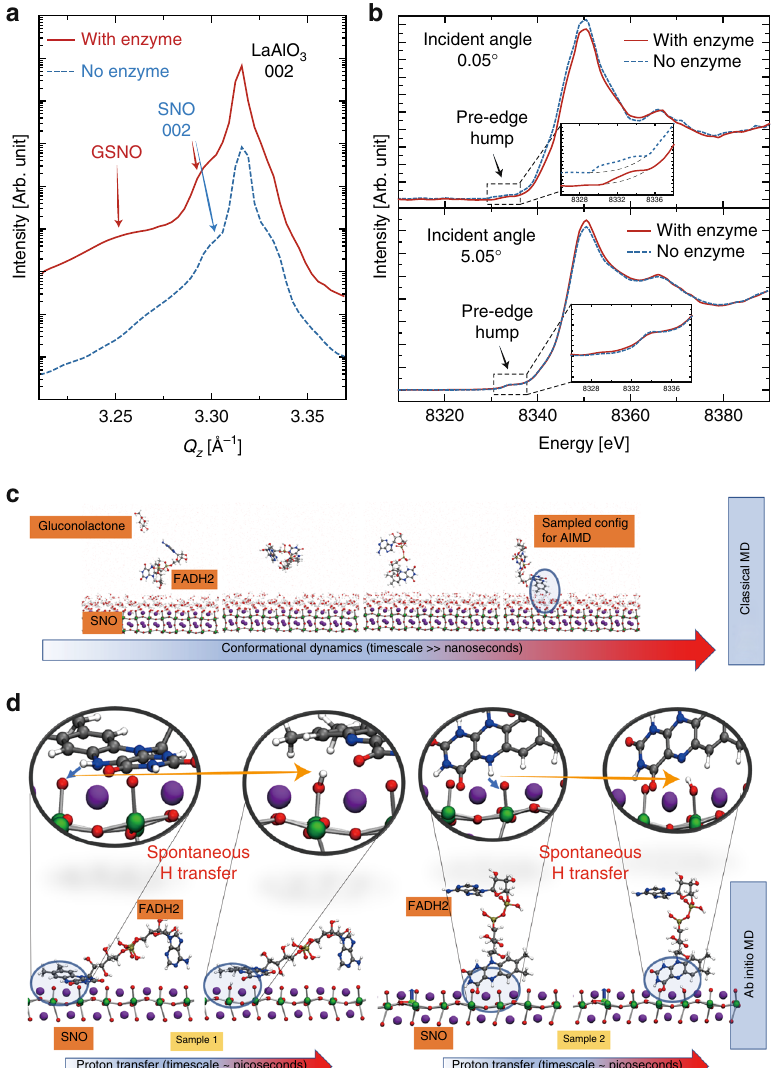
Fig. 3 Mechanism of the spontaneous reaction between the enzyme – SNO device and glucose. a Synchrotron X-ray diffraction scans of glucose-reacted SmNiO 3 (SNO) devices with and without glucose oxidase (GOx) enzyme modi fi cation. The scans are along Q z direction around the 002 peak of LaAlO 3 substrate (pseudocubic notation). b Angle-dependent X-ray absorption near edge spectroscopy (XANES) spectra on glucose-reacted SNO devices with and without GOx enzyme modi fi cation (Ni K-edge). At a surface sensitive incident angle of 0.05 o , XANES spectra acquired on the GOx-modi fi ed electrode on GSNO show pronounced reduction in the white line peak amplitude and the effective pre-edge humps, as compared to the electrode without any GOx, suggesting orbital fi lling at the SNO surface, due to the hydrogen transfer. The blue dashed curve in the fi gure inset is shifted upward for clarity of data presentation. At incidence angle of 5.05 o , XANES spectra acquired on GOx-modi fi ed device shows negligible difference with respect to that without enzyme modi fi cation, which indicates the majority of the fi lm is still pristine SNO. The insets show zoomed-in pre-edge feature in XANES spectra. c Classical MD trajectory of a representative FADH2 molecule. Snapshots show the conformational changes that the FADH2 molecule undergoes over timescales of ~10 ns before approaching the SNO (001) surface (pseudocubic notation). d Several tens of FADH2 near-surface conformations from ~500 ns of classical MD trajectories are sampled and used as starting con fi gurations for AIMD simulations. Two representative samples are illustrated to demonstrate the spontaneous hydrogen transfer from an H site in FADH2 to surface oxygen of SNO (001). In both the depicted cases, one of the hydrogens from FADH2 gets extracted and gets adsorbed into the SNO (001) (zoomed-in view); the extraction process is spontaneous, with an energetic gain as large as 1.8 eV. Classical MD simulations suggest that the steric effects are important and can hinder the hydrogen transfer from FADH2 to SNO (001) as shown by detailed fi rst principles calculations of representative trajectories (see Supplementary Fig.